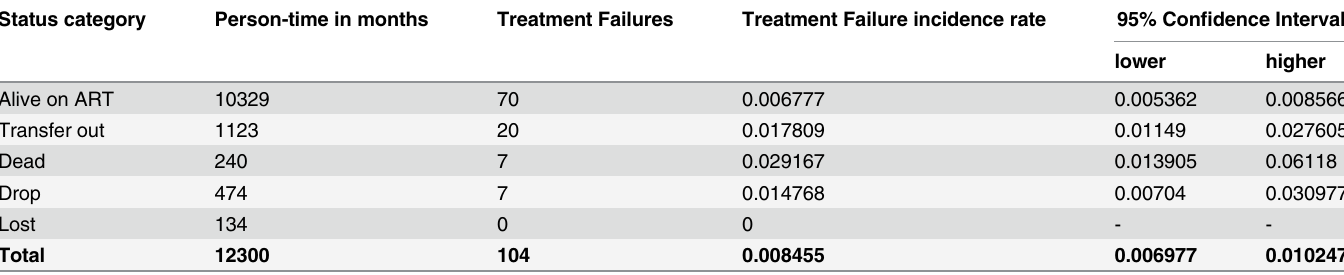
Table 3. Person-time contributed by study subjects by status at the last visit in the private health facilities in Addis Ababa, 2009 – 2013.